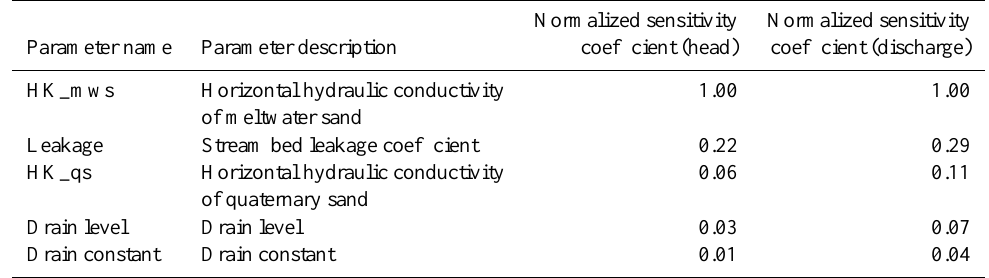
Table 1. List of parameters included for estimation, including their normalized sensitivity coefficients to head and discharge observations,